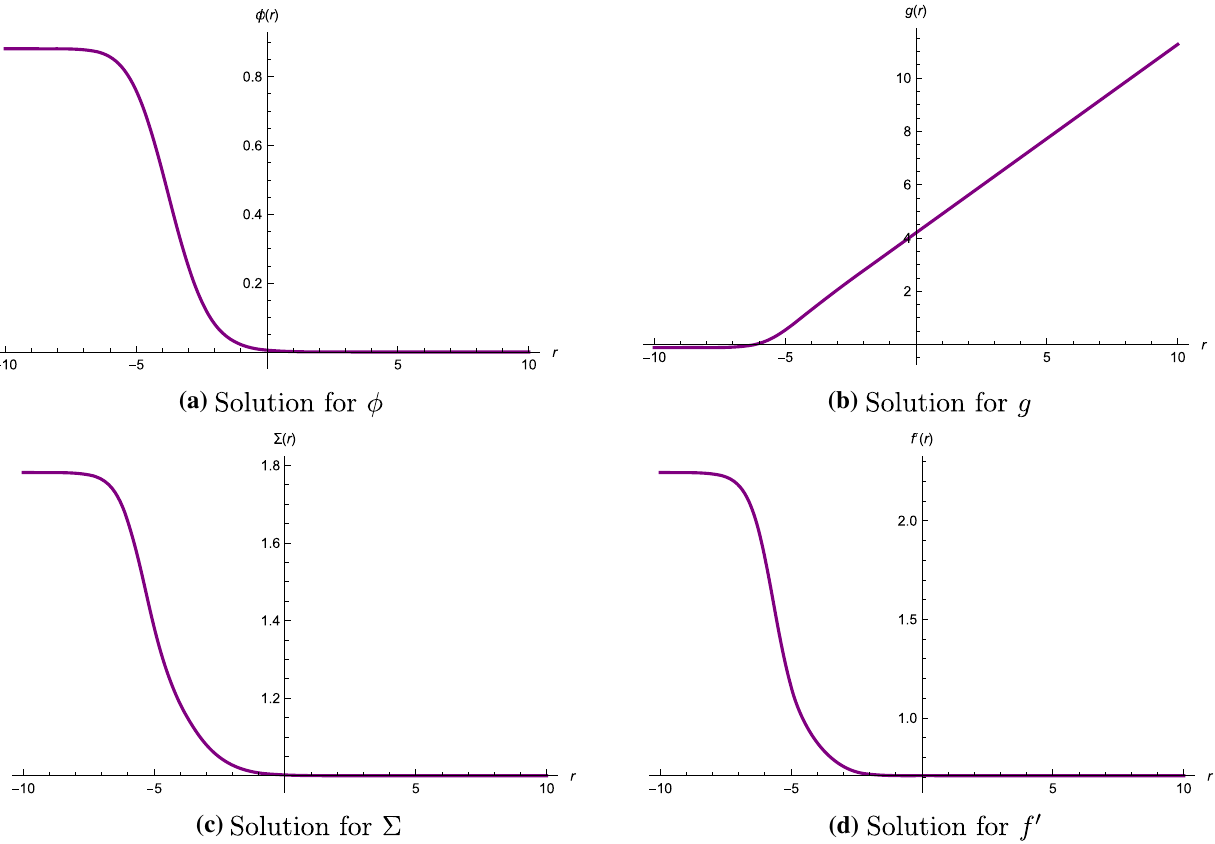
Fig. 7 An RG flow from AdS 5 critical point with U ( 1 ) × SU ( 2 ) × SU ( 2 ) symmetry to AdS 2 × H 3 critical point for g 1 = 1 and g 3 = 2 g 1 vacua and the AdS 2 × H 3 solution in (85) are shown in